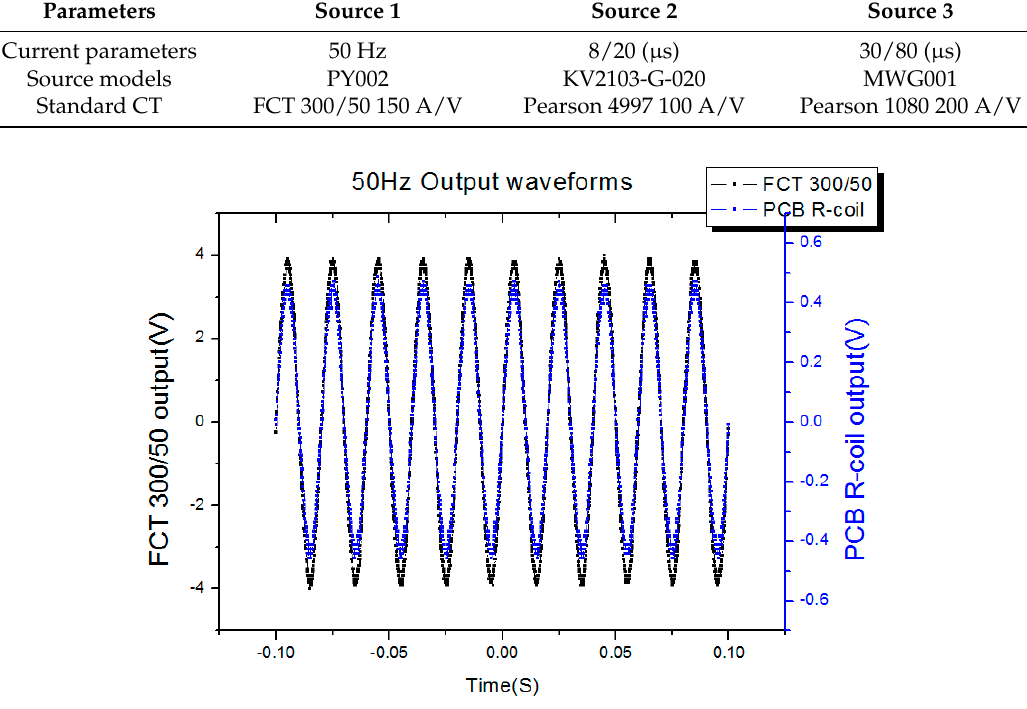
Figure 15. 50 Hz output waveforms.